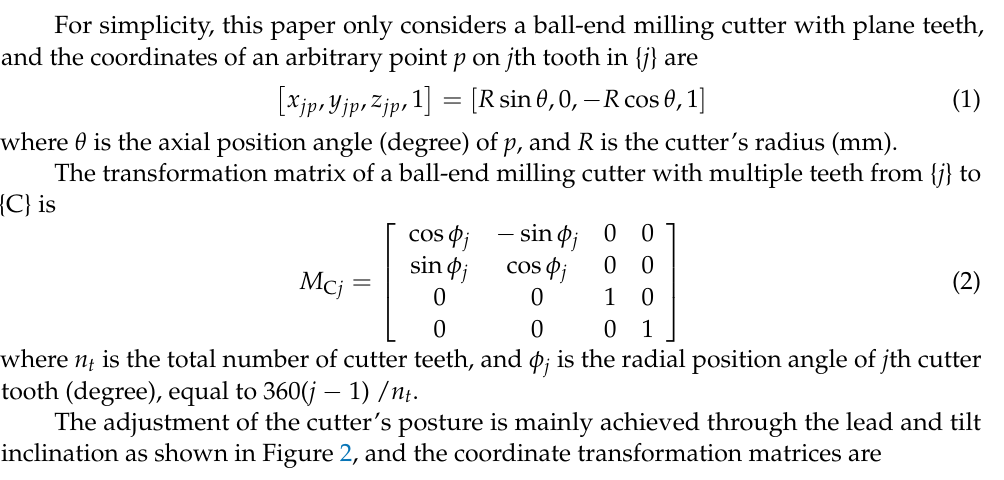
Figure 1. Cutter tooth trajectory reference coordinate